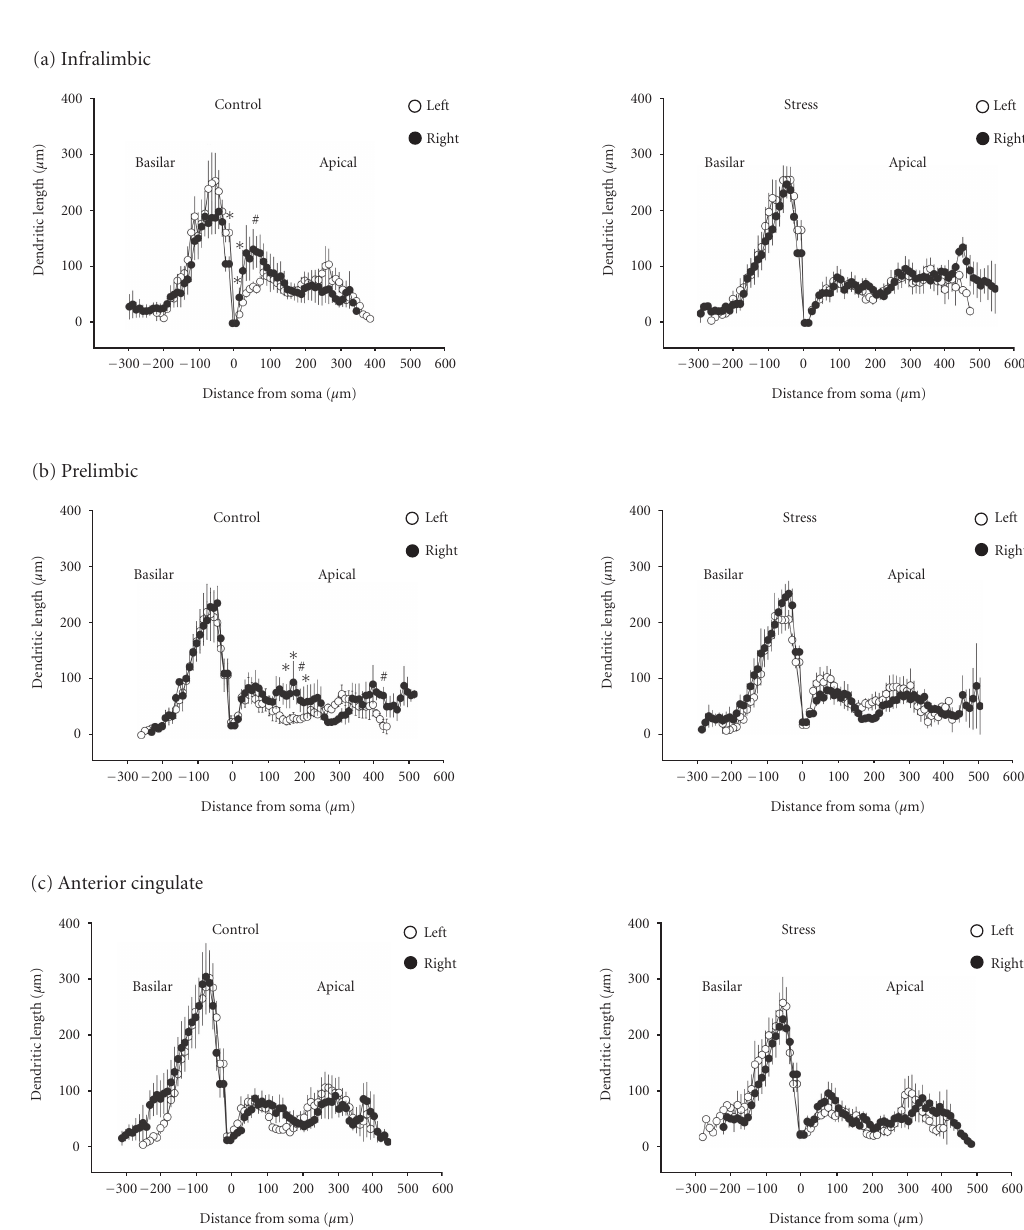
Figure 3: Sholl analysis of dendrites on pyramidal cells in the left (open circles) and the right hemisphere (closed circles) of controls (left panel) and stressed rats (right panel). Basilar dendrites are plotted to the left and apical dendrites to the right as a function of the distance from the soma center (0). The schematic drawing in the top panel illustrates the Sholl circles that correspond to the distances from soma depicted in (a) infralimbic, (b) prelimbic, and (c) anterior cingulate. Data points represent the sum of all dendrites detected at the respective distance (radius) from the soma center set as zero (mean ± SEM). Symbols indicate significant di ff erences within each 10 µ m ring determined by ANOVA with Bonferroni’s post hoc test ( ∗ P < . 05, # P < .